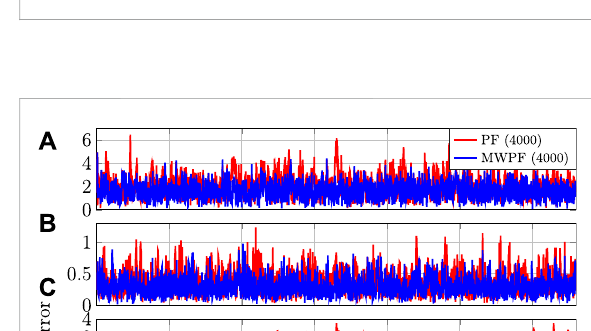
FIGURE 5 Comparison of PF and MW-PF solutions (in east-north reference frame) applied to position estimation of a static GNSS receiver for N =2000. Mean value of the estimate and 3- σ uncertainty in the form of error ellipses are also depicted for the two distributions. The ground truth is located in (0,0).